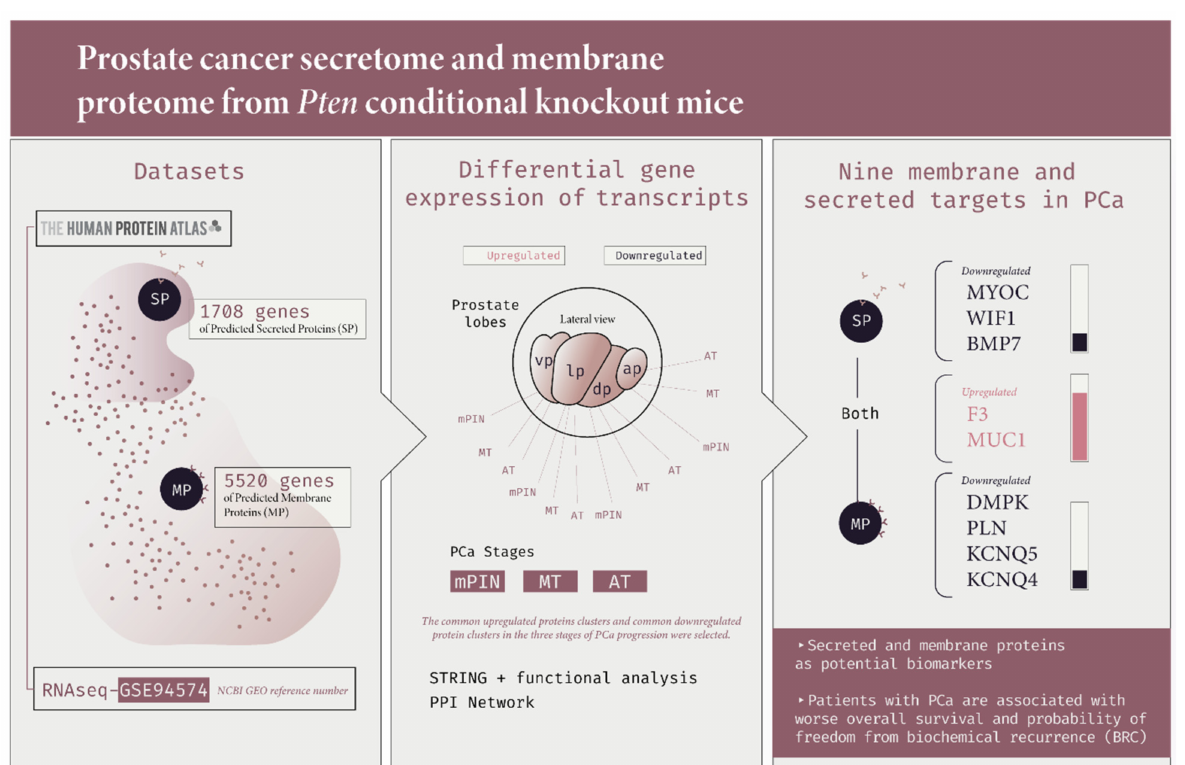
Figure 10. An overview of the main methodological strategies and results of prostate cancer secretome and membrane proteome from Pten conditional knockout mice and human prostate cancer. Here, we combined the selection of transcripts from the list of protein-coding genes of the secretome and membrane proteome dataset using The Human Protein Atlas Secretome and the Pten conditional knockout mice dataset (GSE 94574). After finding the upregulated and downregulated genes in the mPIN, MT and AT stages of PCa, we performed the GO enrichment analysis, PPI network using the STRING database, and the gene expression levels of the targets using the online GEPIA tool. Finally, we obtained nine ( DMPK , PLN , KCNQ5 , KCNQ4 , MYOC , WIF1 , BMP7 , F3 , and MUC1 ) deregulated PMPs and PSPs potential biomarker targets in